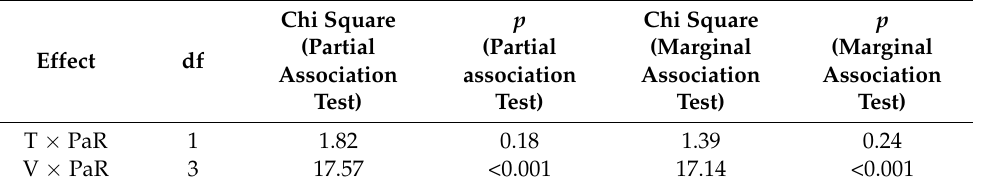
Table 5. Log linear results showing the effect of each factor (T = treatment; V = vineyard) on parasitization rate on randomly-collected bunches (PaR = parasitization rate on randomly-collected bunches).